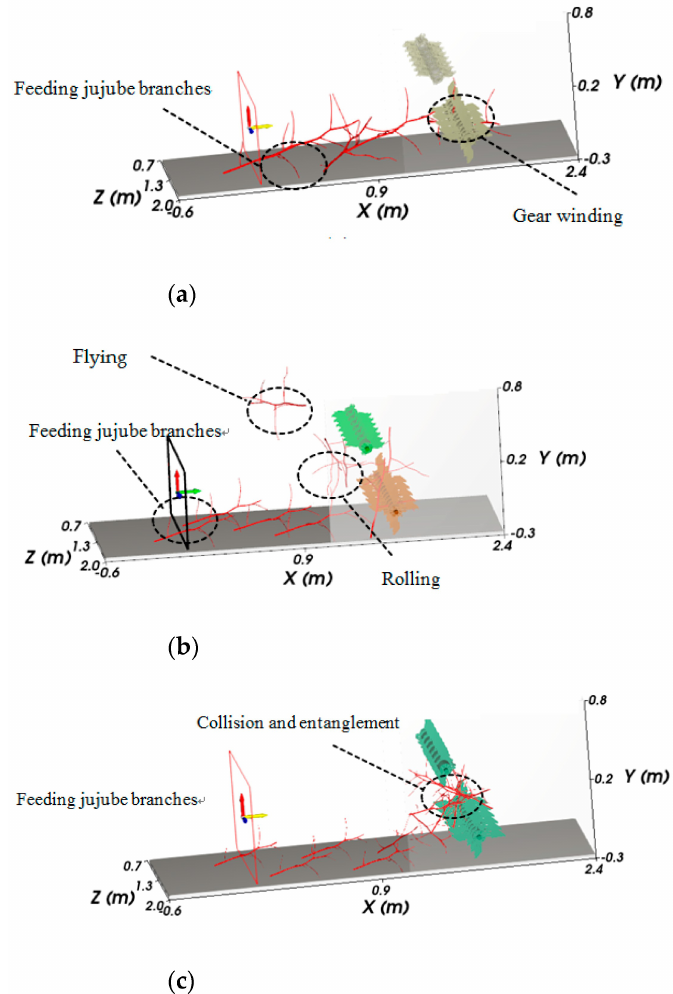
Figure 10. Influence of the gear rotation speed on the movement of jujube branches. ( a ) Gear rotation speed is 100 r/min. ( b ) Gear rotation speed is 120 r/min. ( c ) Gear rotation speed is 150 r/min. It can be found from Figure 11 that with the increase in gear rotation speed, the collision effect between particles becomes stronger and the particle pickup rate decreases.